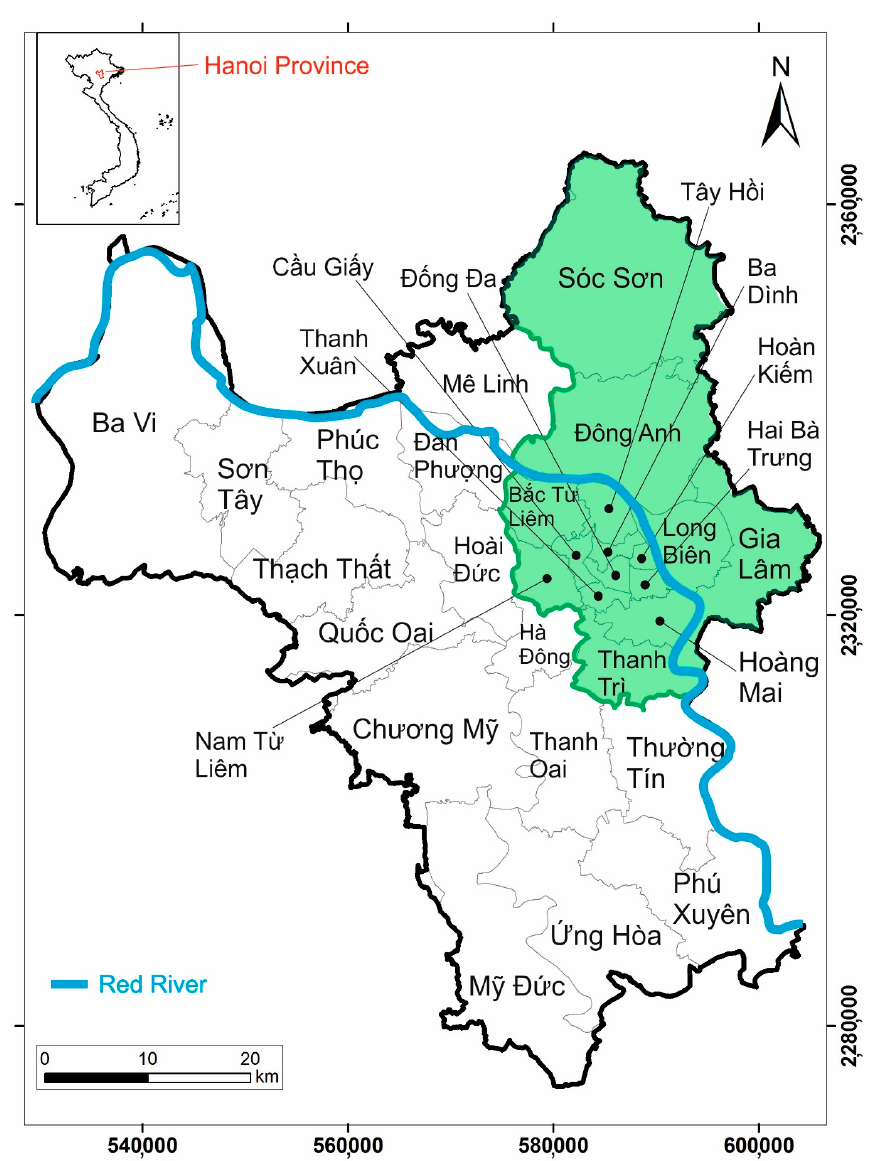
Figure 1. Location map of the main administrative boundaries of the 30 districts within the Hanoi Province with an indication of the pre-2008 Hanoi Province in green and the newly added area in white, previously known as Ha Tay Province. Coordinate system: WGS1984, UTM Zone 48N.